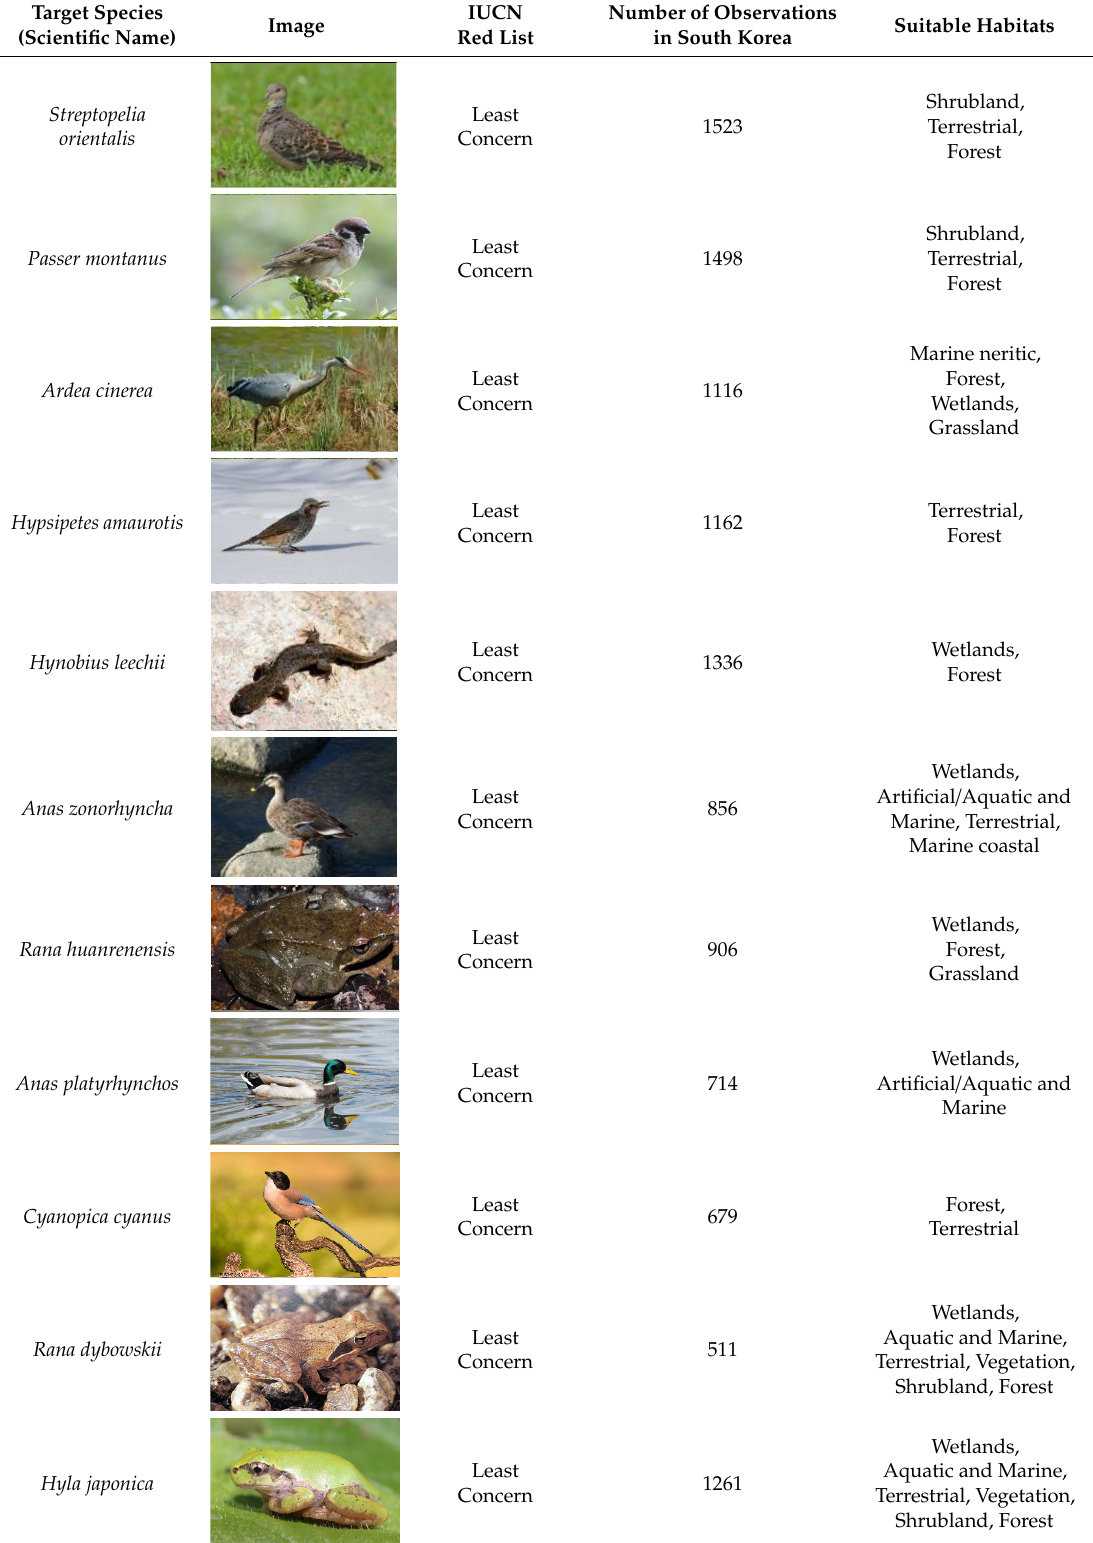
Table 2. Target species and their observations.